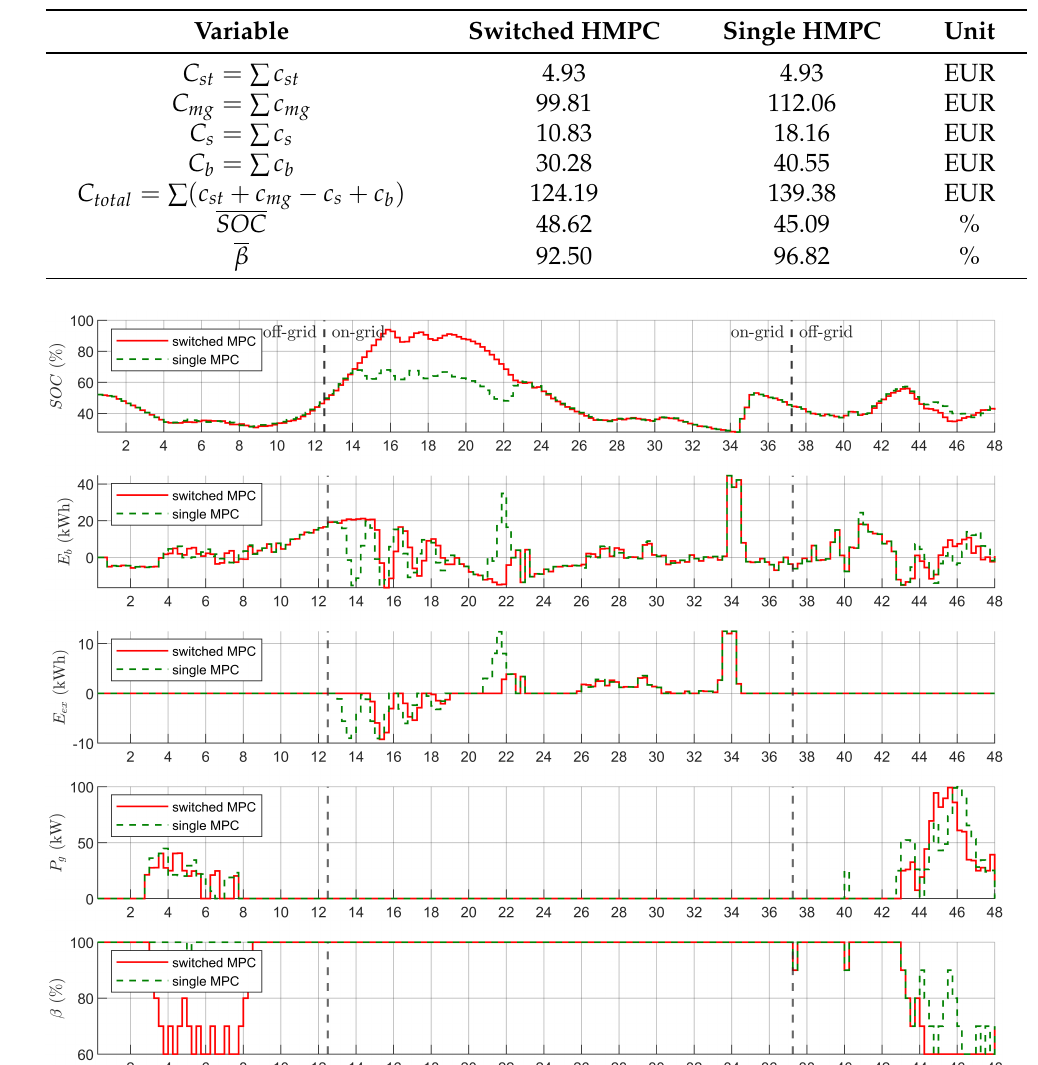
Table 3. Aggregated output values associated with microgrid operation cost and averaged state of charge and energy demand reduction coefficient values obtained using switched and single hybrid MPC solutions in the two-day scenario.